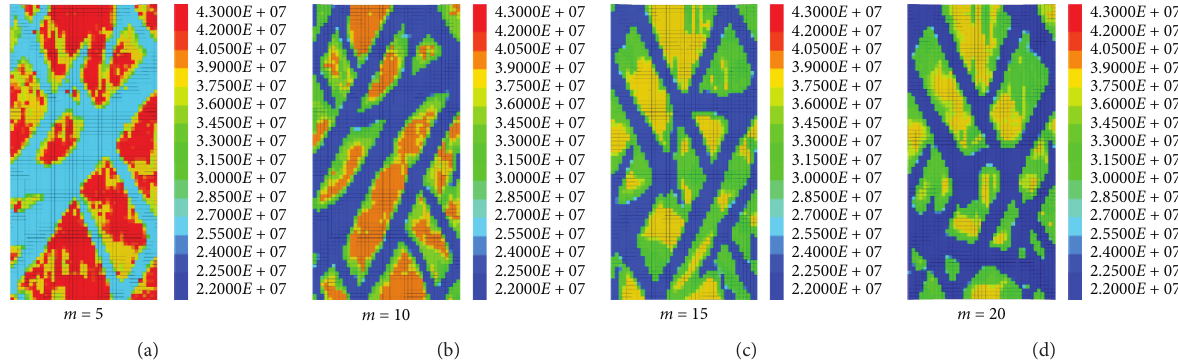
Figure 8: Cohesion distribution in models after failure with different homogeneity m under the confining pressure 20 MPa. (a) m � 5. (b) m � 10. (c) m � 15. (d) m � 20.